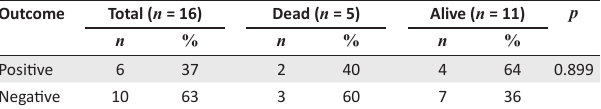
TABLE 5: Outcome by human immunodeficiency virus (HIV) status in children.